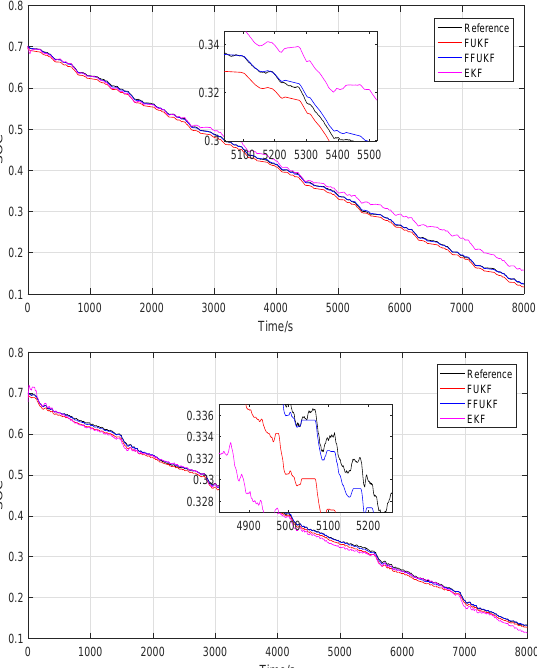
Figure 10. The SOC estimation curves under BJDST and FUDS at 25 ◦ C.